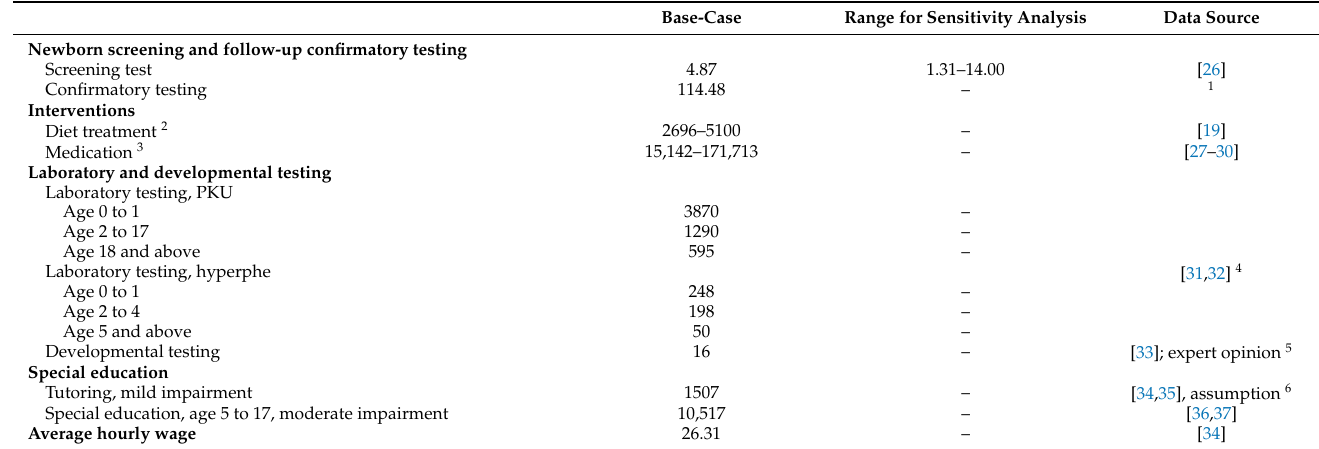
Table 2. Costs, 2017 US Dollars.